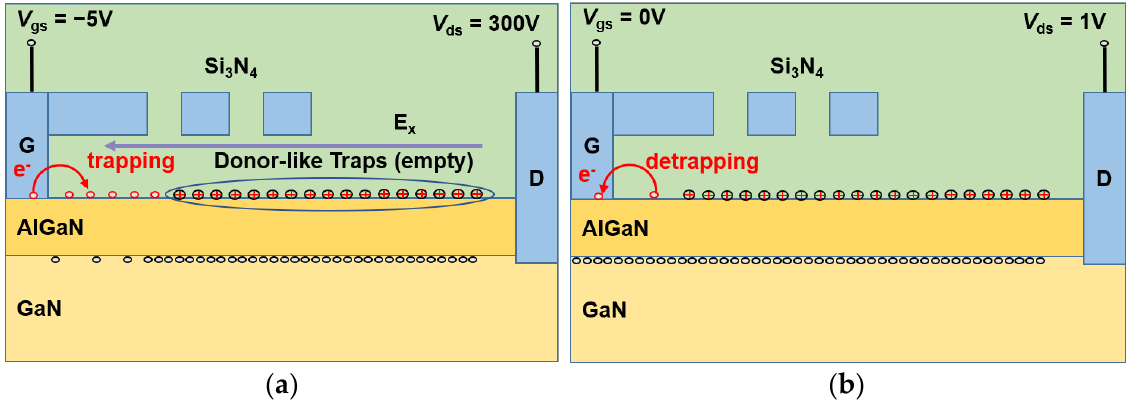
Figure 4. Schematic diagrams of ( a ) the OFF-state electrons inject-out process and ( b ) the ON-state electron inject-in process in the 2FFP structure.